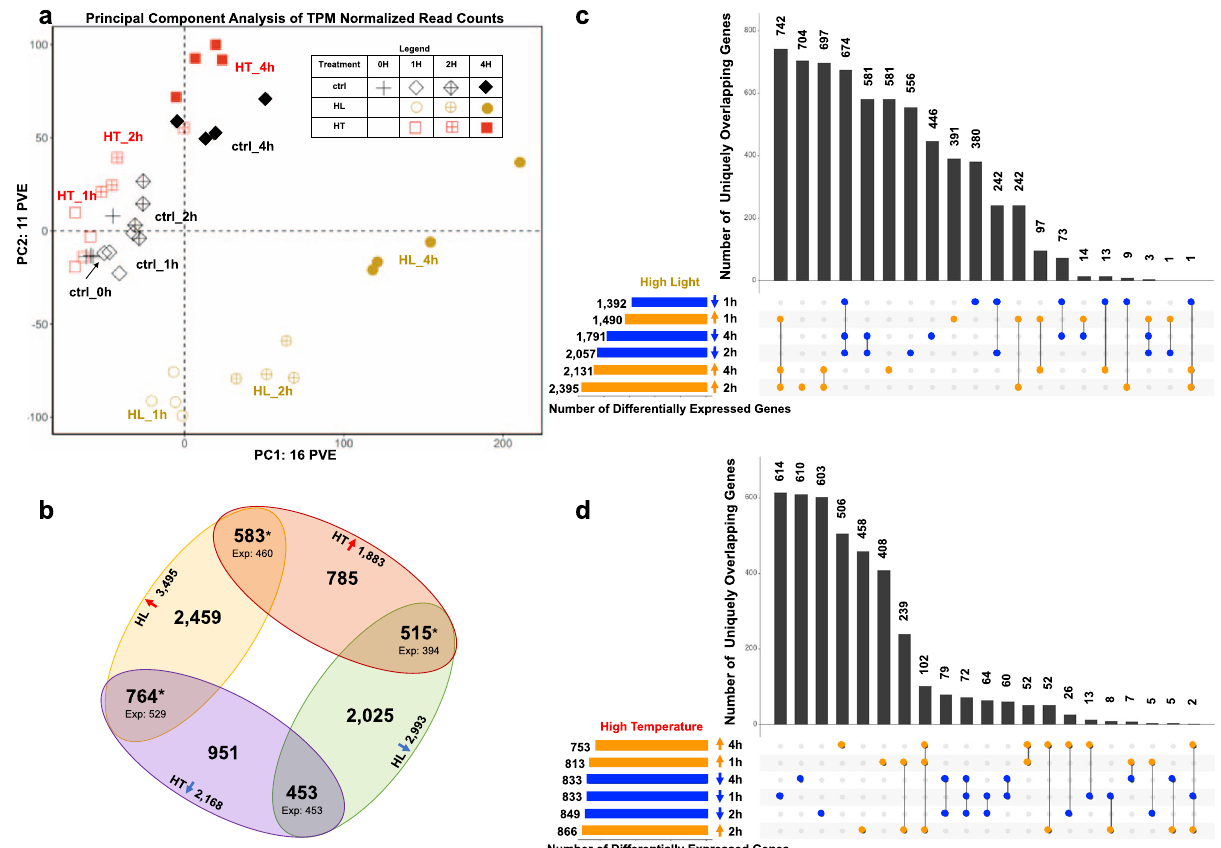
Fig. 2 Time-course transcriptome data reveal dynamic responses to high light or high temperature in S. viridis . a Principal component analysis of TPM (transcripts per million) normalized read counts in control, high-light-, and high-temperature-treated samples. The fi rst two principal components (PC) representing the highest percent variance explained are displayed. PC1 explains 16% of the variance in the dataset and mainly separates the samples based on time. PC2 explains 11% of the variance in the dataset and mainly separates the high light samples from the control and high temperature samples. Black diamonds indicate control samples, yellow circles indicate high light samples, and red squares indicate high temperature samples. Different fi llings for these symbols indicate different time points of each treatment. Each treatment and time point have four biological replicates, represented by symbols with the same shape and color. b High light and high temperature treatments had more overlapping differentially expressed genes than expected by random chance. Gene sets represent the number of genes differentially regulated in at least one time point in the given condition. Red upward arrows denote up-regulation and blue downward arrows denote down-regulation. Yellow oval denotes high light up-regulated genes, green oval denotes high light down-regulated genes, red oval denotes high temperature up-regulated genes, purple oval denotes high temperature down-regulated genes. Expected values (Exp) are the number of the overlapping genes expected by random chance based on size of the gene lists and background of all genes tested via DeSeq2 (14,302). Numbers above expected values are the actual number of overlapped genes between two conditions. * p < 0.0001, Fisher ’ s exact test. c , d High temperature transcriptional responses are more transient than high light. UpSetR plots show number of uniquely overlapping genes between up- and down-regulated gene sets at each time point in high light and high temperature, respectively. Horizontal bars indicate the number of genes up- or down-regulated at each time point. Filled circles indicate the gene sets included in the overlap shown. Vertical bars indicate the number of genes represented in the overlap shown. Overlapping gene sets are arranged in descending order by number of genes. Genes may only belong to a single overlapping gene set and are sorted into the overlapping set with the highest number of